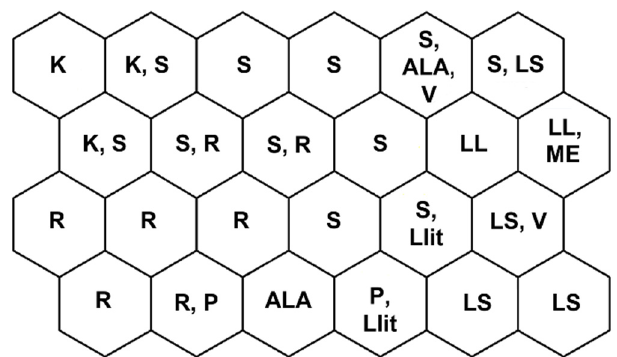
Figure 1. Unsupervised map of sites clustered by habitat. Habitat types considered are: kryal (K), krenal (S), rhithral (R), potamal (P), small (LS) and large (LL) lakes, Alpine lakes (ALA), Mediterranean (ME), and volcanic (V) lakes and lake-vegetated littorals (Llit). The cold stenothermal taxa living in kryal zone or in cold mountain springs, such as Parorthocladius nudipennis and Chaetocladius, were clustered in cell 19 (Figure 2). Diamesa bertrami , Eukiefferiella brevicalcar, and E. minor were clustered in cells 19 and 20 (Figure 2), D. latitarsis and D. zernyi were clustered in cells 13, 19, and 20; D. dampfi , Paratrichocladius skirwithensis, and Pseudodiamesa inhabitants of cold mountain springs were aggregated in cells 13 and 19 (Figure 2).